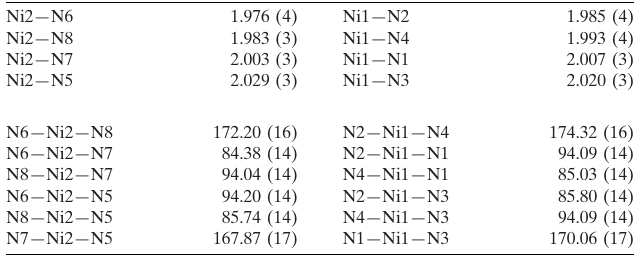
Selected geometric parameters (A˚ , (cid:4) ).